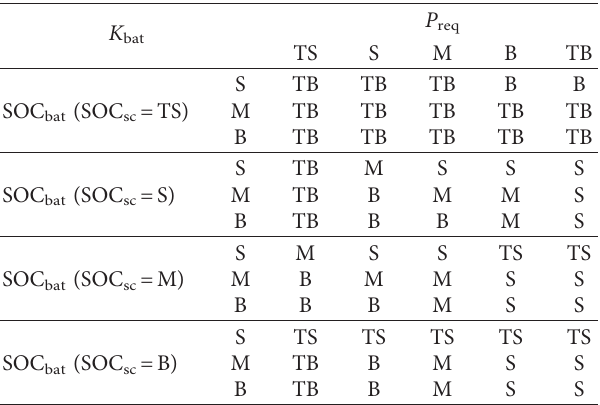
Table 5: Fuzzy rules in discharge